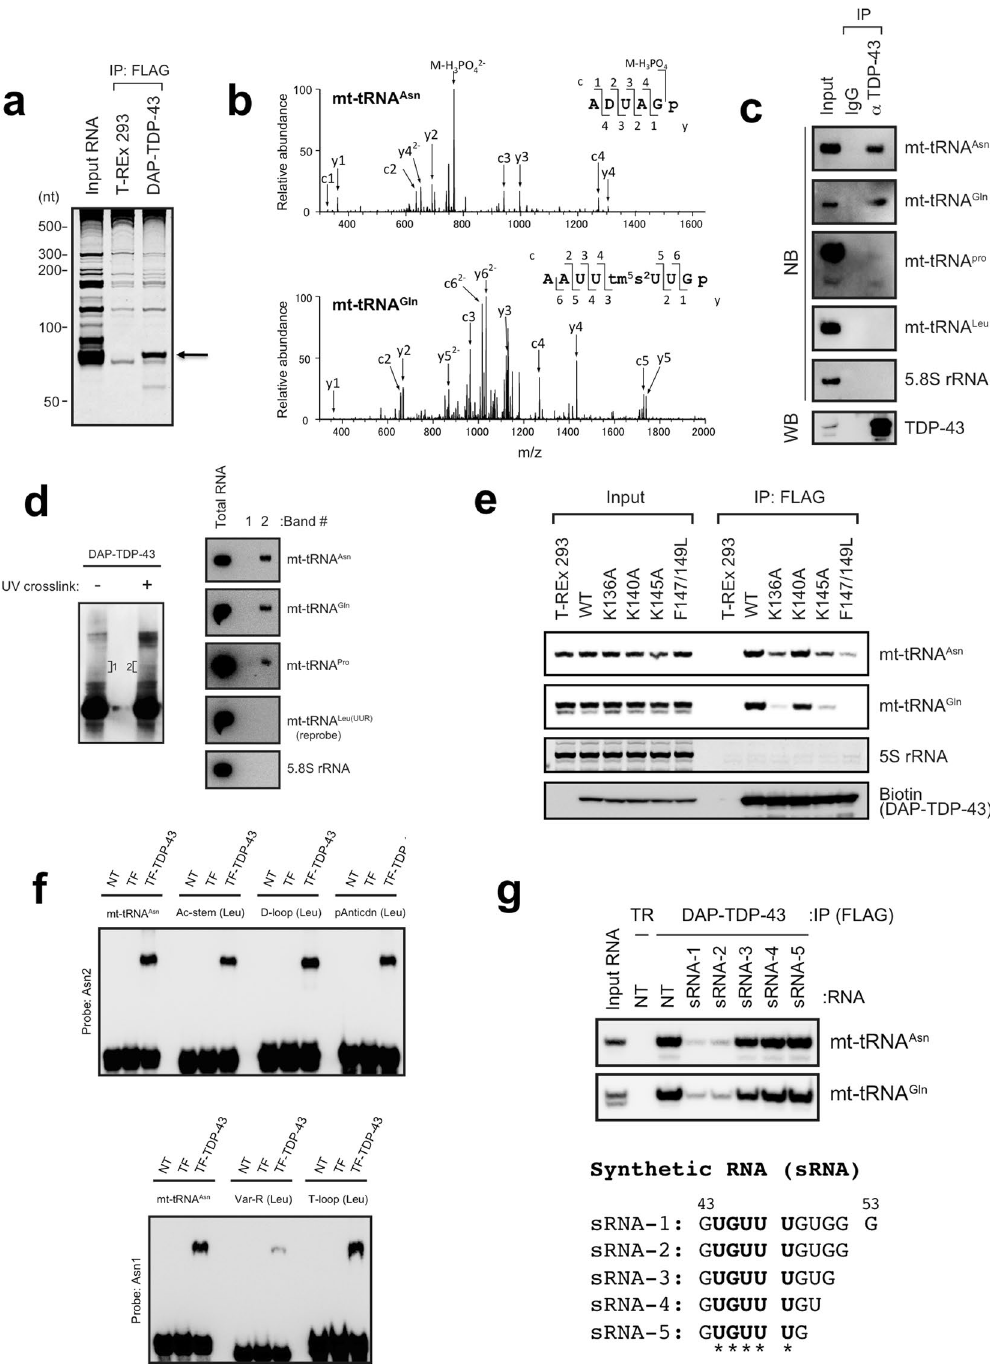
Figure 1. TDP-43 associates with a subset of L-strand-encoded mt-tRNAs. ( a ) RNAs immunoprecipitated (IP) from DAP (double affinity purification tag, see Supplementary Fig. 1a)-TDP-43–expressing cells or T-REx 293 cells were stained with SYBR Gold. ( b ) A typical MS/MS spectrum of the oligonucleotide [ADUAGp] 2 − that originated from the RNase T1 digest of mt-tRNA Asn (top) or [AAUUtm 5 s 2 UUGp] 2 − from that of mt-tRNA Gln (bottom). m/z, mass-to-charge ratio. ( c ) Endogenous TDP-43 was immunoprecipitated with anti-TDP-43 ( α TDP-43) and analysed by western blotting (WB) with anti-TDP-43. The immunoprecipitated RNAs were detected by northern blotting (NB) with the probes indicated on the right. Rabbit IgG served as a negative control. ( d ) DAP-TDP-43 complex was immunoprecipitated from DAP-TDP-43-expressing T-REx 293 cells with ( + ) or without ( − ) UV crosslinking, separated by SDS-PAGE, and detected by WB with horseradish peroxidase (HRP)-conjugated streptavidin (left). The SDS-PAGE gel bands containing RNA-bound DAP- TDP-43 corresponding to the area indicated as 1 and 2 were excised, and RNAs were extracted from the bands and analysed by NB with RNA-specific probes (right). ( e ) Each DAP-TDP-43 mutant bearing a mutation(s) at residue(s) K136, K140, K145, or F147/L149 was immunoprecipitated with anti-FLAG and analysed